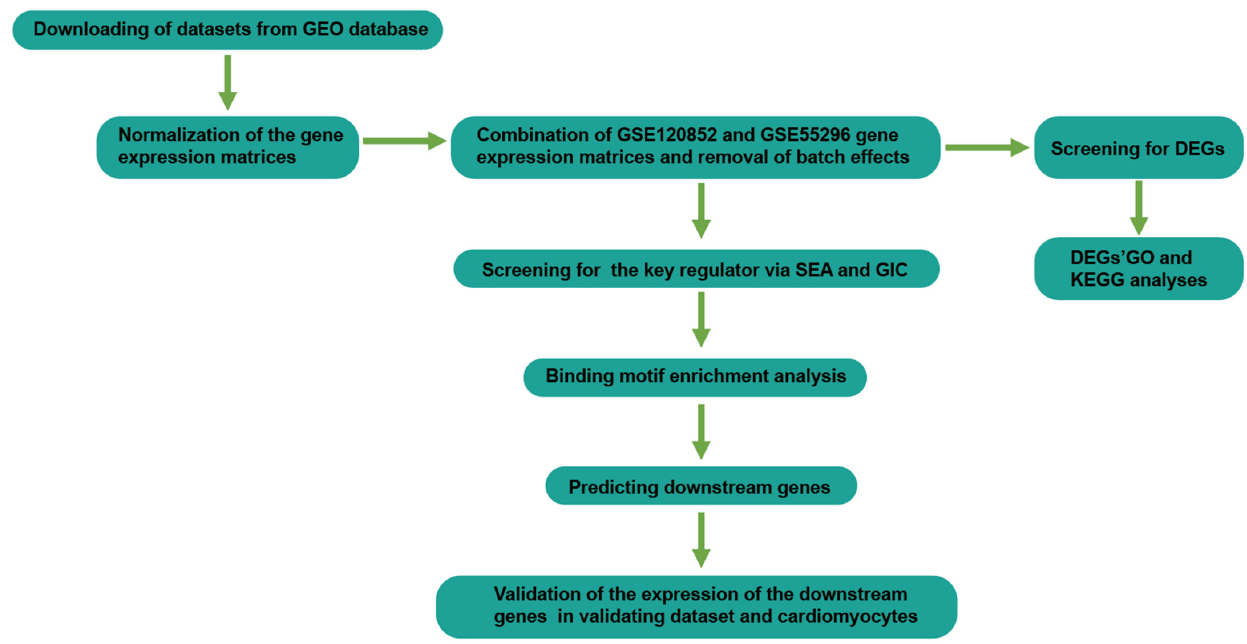
Figure 1. Workflow of the study design.